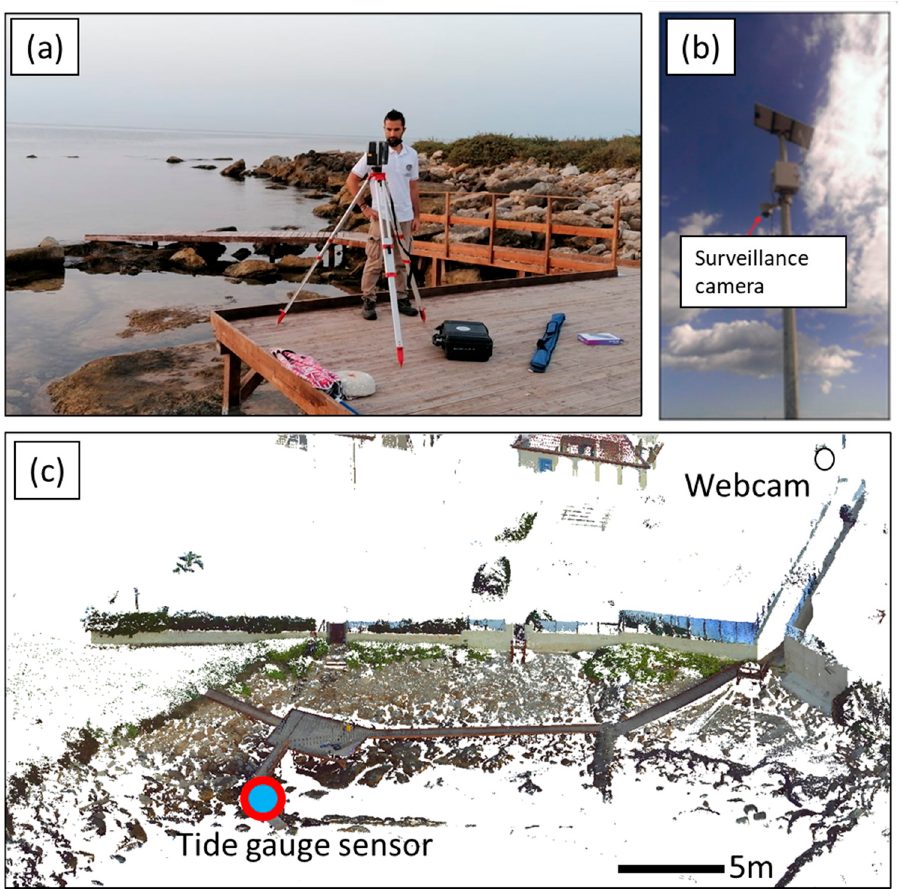
Figure 3. Topographic data: ( a )-Topographic survey performed through TLS on Varco 11; ( b )—sur- veillance camera of MPA; ( c )—point clouds of TLS data of Varco 11 with ubications of the webcam and tide gauge